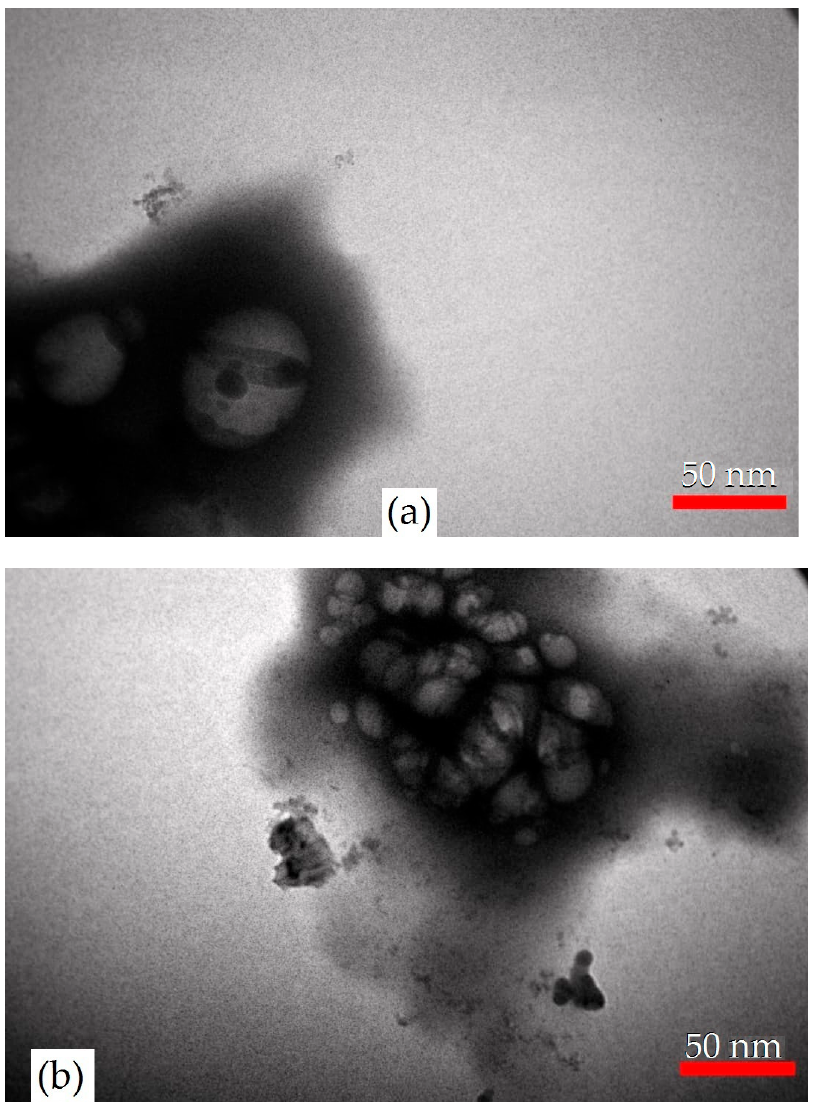
Figure 2. Transmission electron microscopes photographs of UF resin mixed with 1.5% ( a ) and 4% ( b ) nano SiO 2 particles.